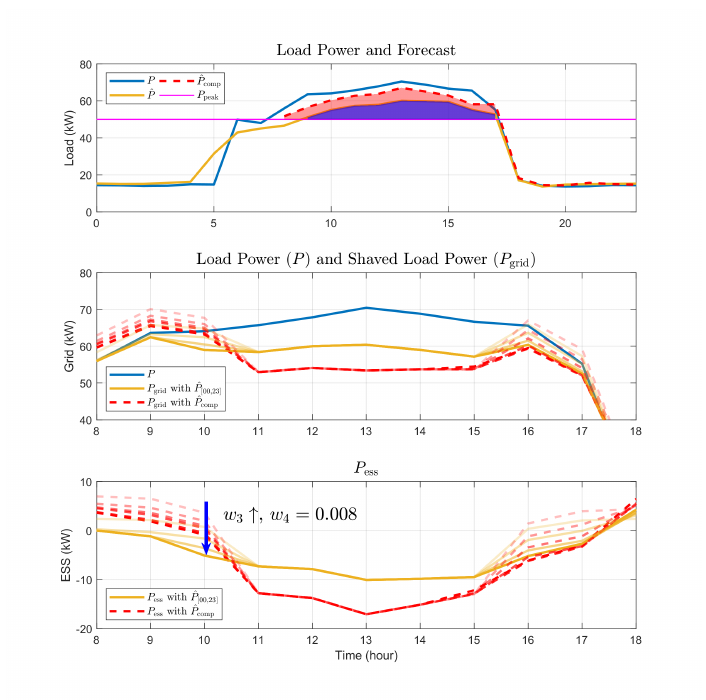
Figure 18. Effect of Weights w 3 on the Amount of Peak Shaving.